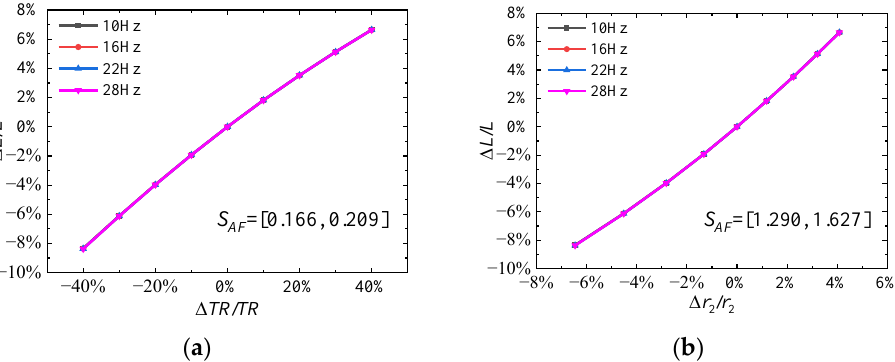
Figure 13. Sensitivity analysis for the dimensionless radius of the second moment of area r 2 by modulating the taper ratio λ . ( a ) Variation of lift vs. variation of λ . ( b ) Variation of lift vs. variation of r 2 .